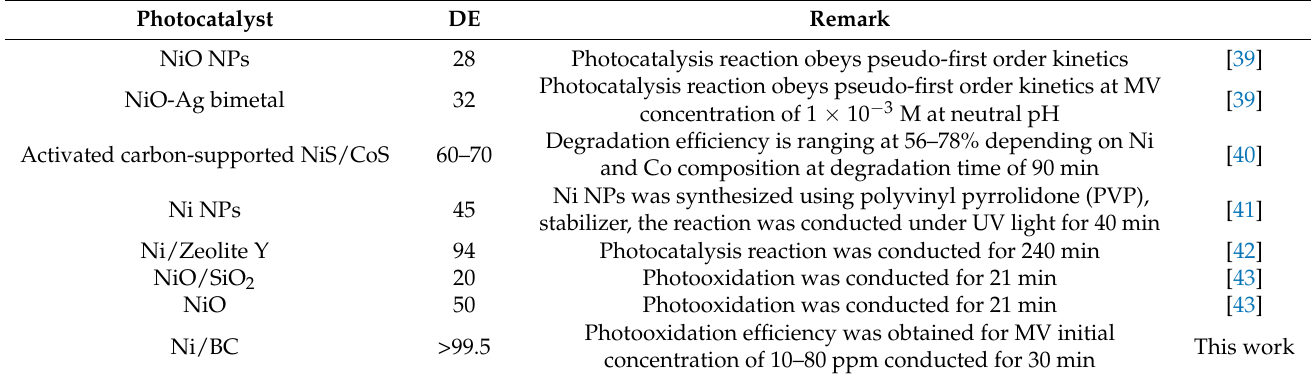
Table 4. Comparison on activity of Ni and NiO-based photocatalyst in MV